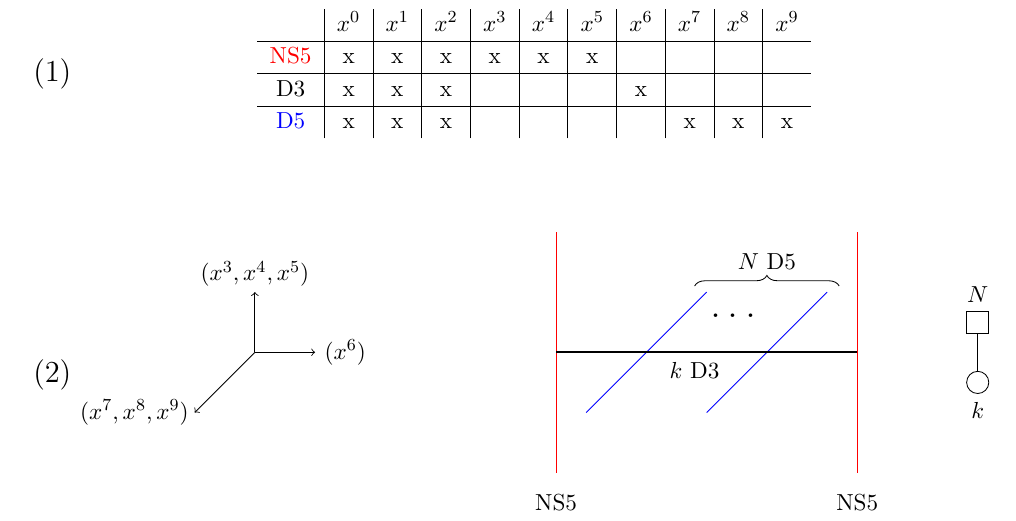
Figure 5 . (1) The Type IIB set-up: the ’x’ mark the spacetime directions spanned by the various branes. The x 6 direction can be seen as an S 1 direction when we engineer unframed affine quivers later in this section. (2) Depiction of the brane system for U( k ) with N flavors, with all deformation parameters turned off, at the origin of its moduli